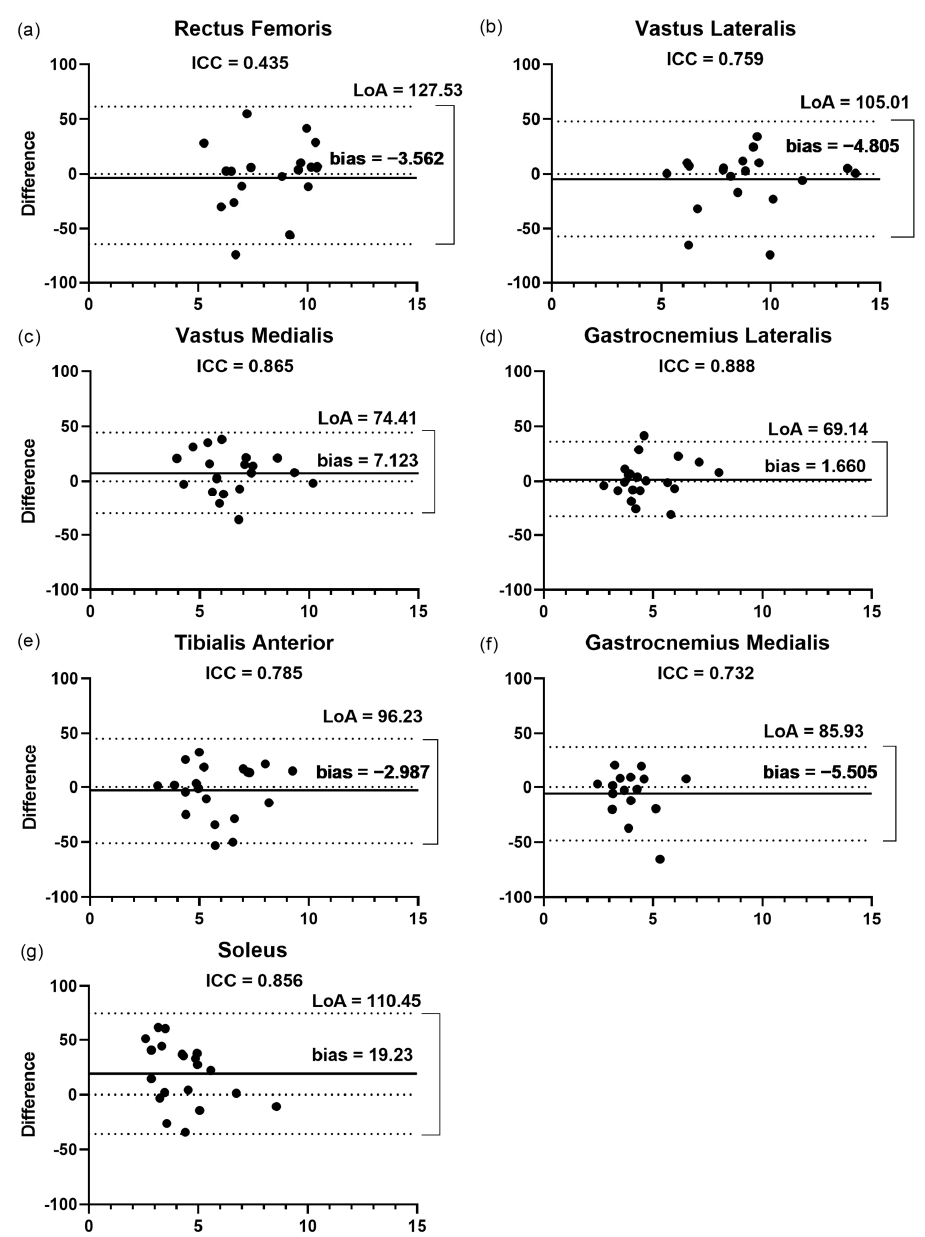
Figure 3. Bland–Altman plots displaying the differences (expressed as %) plotted against the average Lf recorded by the two raters for each muscle. ( a – g ) Inter-rater reliability of Lf measurement for ( a ) rectus femoris; ( b ) vastus lateralis; ( c ) vastus medialis; ( d ) gastrocnemius lateralis; ( e ) tibialis anterior; ( f ) gastrocnemius medialis; and ( g ) soleus. The lines show the zero, bias, and random error lines. Dashed lines represent the 95% limits of agreement (LoA). Lf, fascicular length; LoA, limits of agreement.